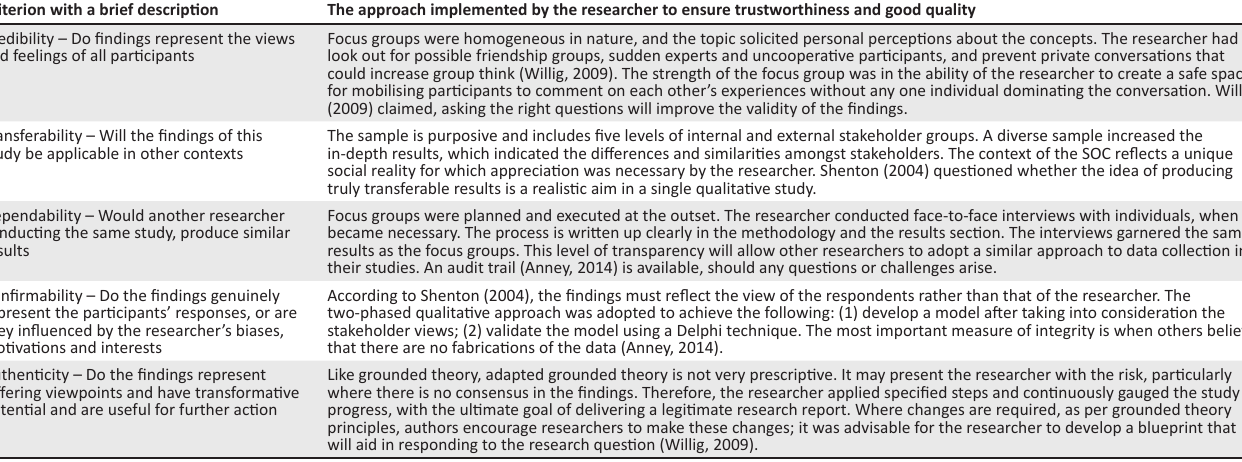
TABLE 1-A1: Provisions made to ensure quality research.